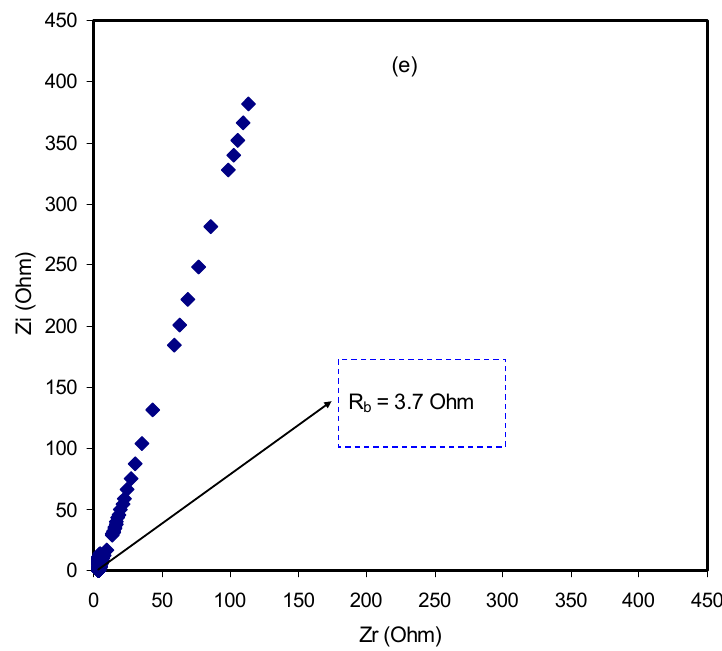
Figure 5. Experimental Impedance plots for ( a ) pure CS:Dextran film ( b ) CSDPB1, ( c ) CSDPB2, ( d ) CSDPB3, and ( e ) CSDPB4 blend electrolyte films.